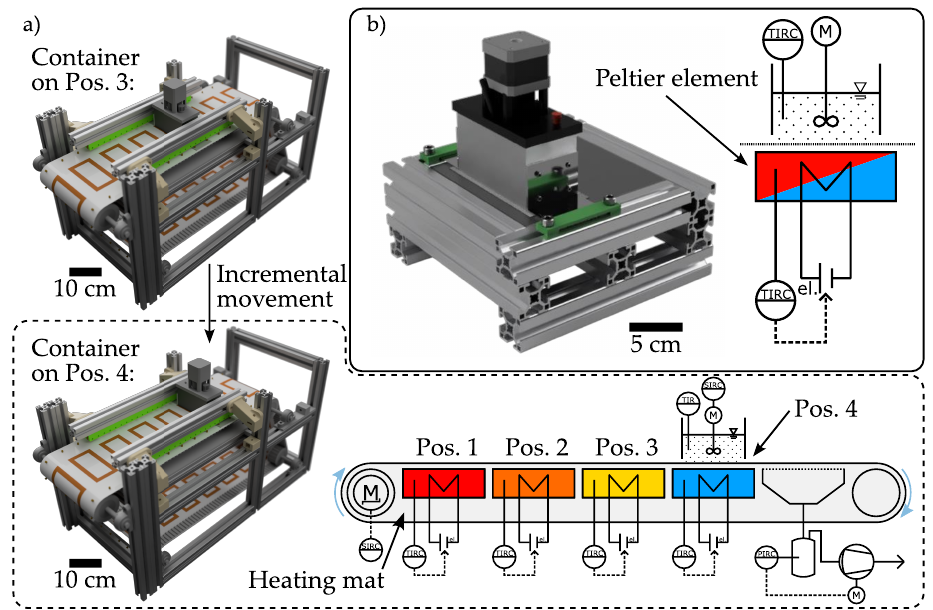
Figure 1. Functional principle of the continuous mini-pant ( a ) and the benchtop setup ( b ). The incremental movement of the process medium container is illustrated. The dotted line circles around the CAD and the P&ID of apparatus with the container positioned on the last temperature